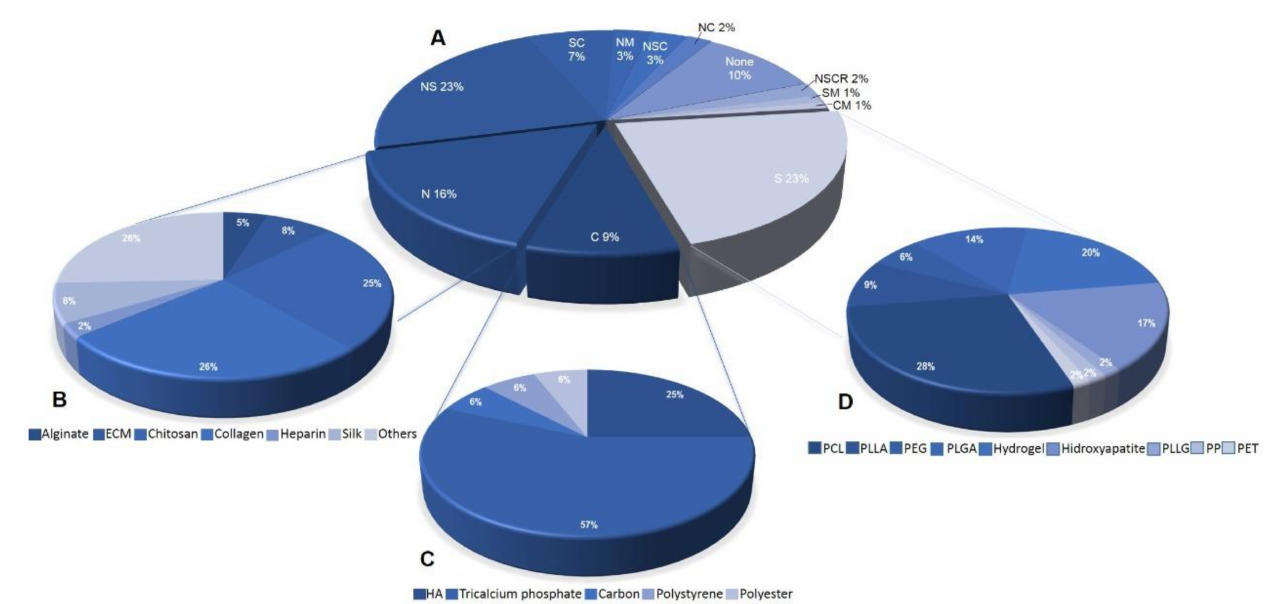
Figure 5. ( A ) Types of biomaterial associated with AD-MSC for regenerative medicine. S (synthetic polymers), N (natural polymers), C (composite), NS (natural and synthetic polymers), SC (synthetic polymers and composite), NM (natural polymers and metals), NC (natural polymers and composite), NSC (natural and synthetic polymers and composite), NSCR (natural and synthetic polymers and ceramics), SM (synthetic polymers and metal), CM (composite and metal) and None (not used or not reported). ( B ) Types of natural polymers (alginate, extracellular matrix, chitosan, collagen, heparin, silk and others). ( C ) Types of composites (HA, hyaluronic acid, tricalcium phosphate, carbon, polystyrene and polyester). ( D )